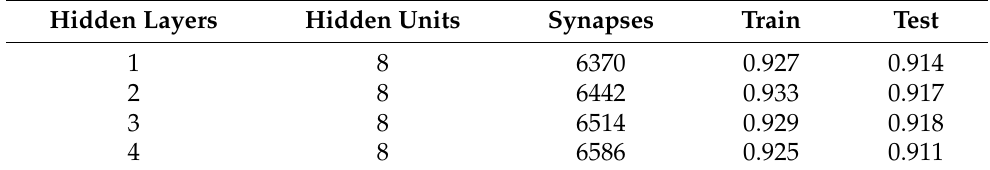
Table 5. Architectures for FdNN with a number of synapses between 4096 and 8192.